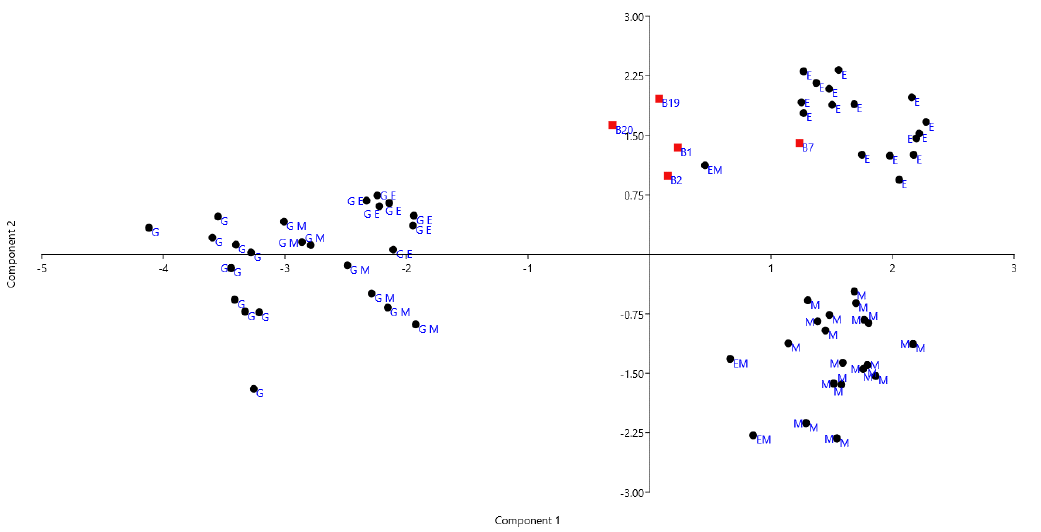
Figure 11. PCA score plot of wall painting samples and reference materials (painted models simu- lating ancient polychromies, containing G: animal glue; GE: animal glue and egg, GM: animal glue and milk, M: milk; E: egg; EM: egg and milk).